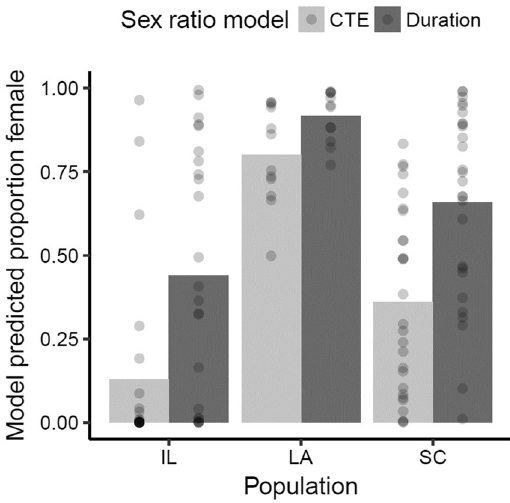
Figure 6. Inter-annual averages (bars) of hatchling cohort sex ratios predicted by the CTE model (light grey) and the DDC Model (dark grey) for each population (IL: Illinois, LA: Louisiana, SC: South Carolina). Points denote estimated sex ratios from an individual